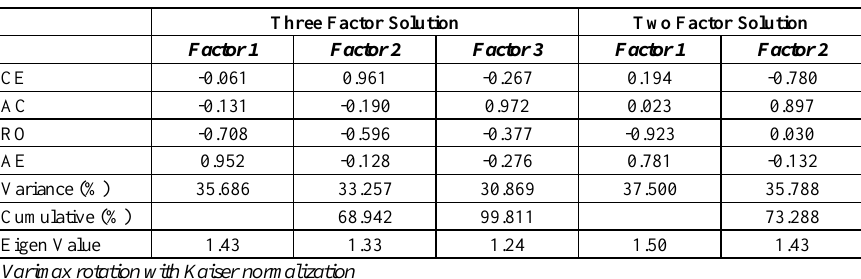
Table 6. Factor analyses of the